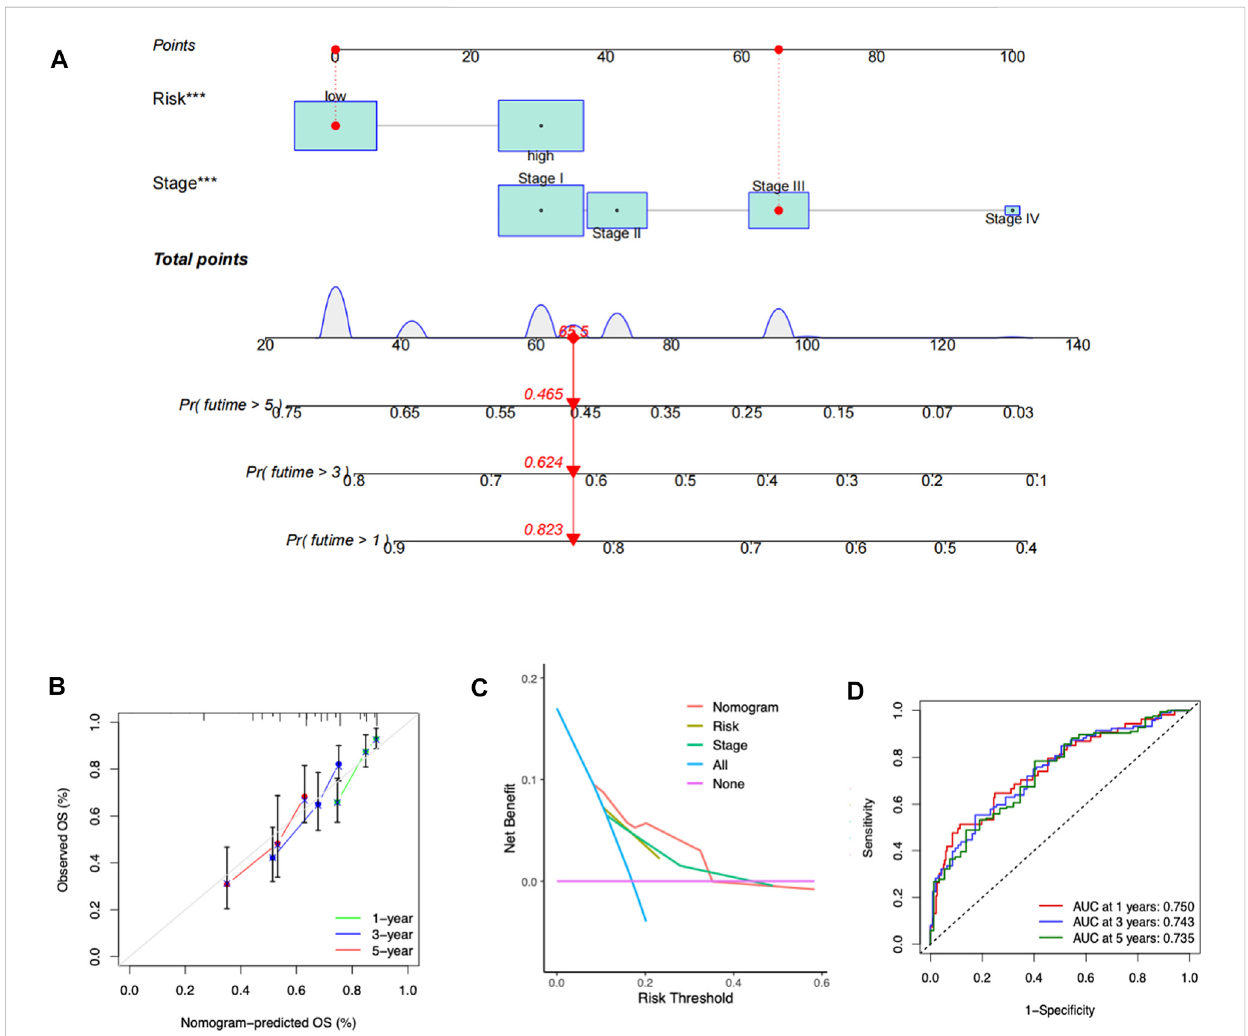
FIGURE 6 ConstructionofanomogrambyclinicopathologicalfactorsandRMScore. (A) PrognosticnomogrambasedonRMScoreandtumorstage. (B) The1-, 3-, and 5-year calibration plots of the nomogram. (C) DCA curves of the nomogram and other clinicopathological parameters. (D) The 1-, 3-, and 5-year ROC curves of the